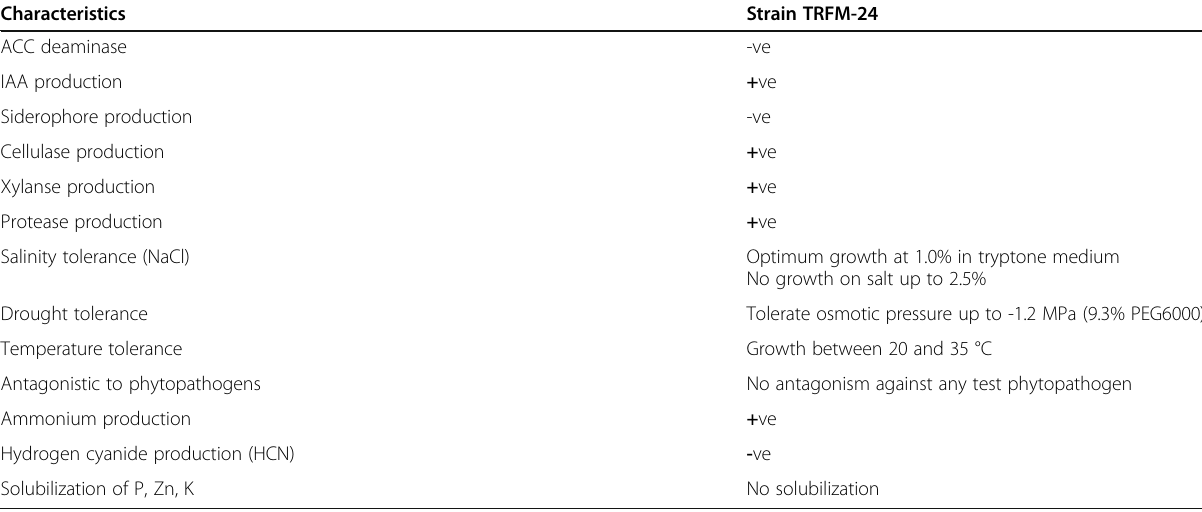
Table 2 Functional characteristics of Chromobacterium vialoceum strain TRFM-24 under in vitro conditions